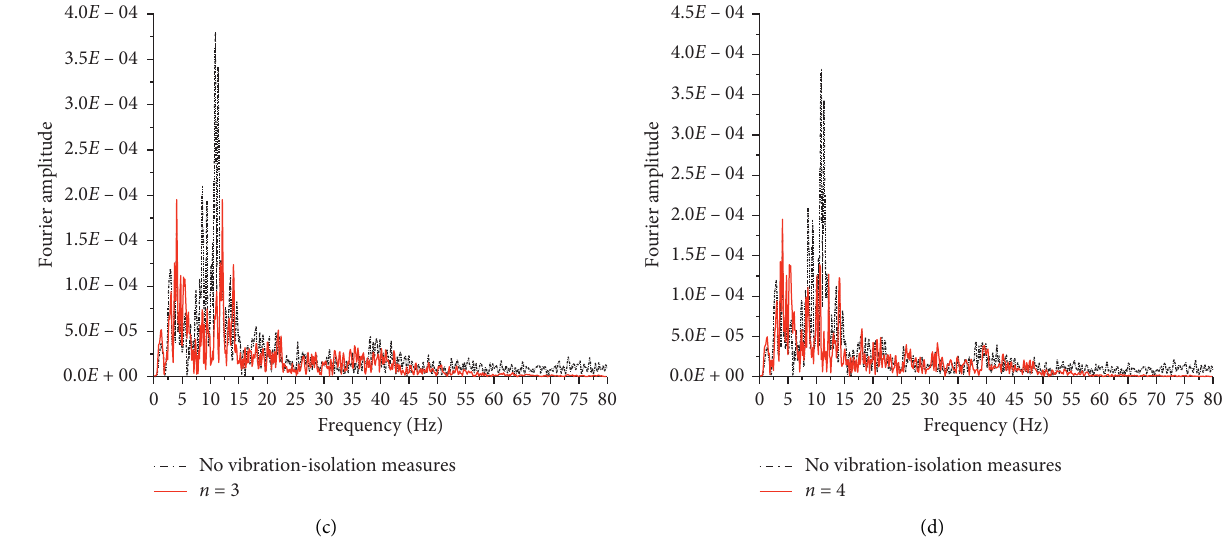
Figure 35: Influence of pile row number ( n ) on vibration-isolation effect (comparison of frequency